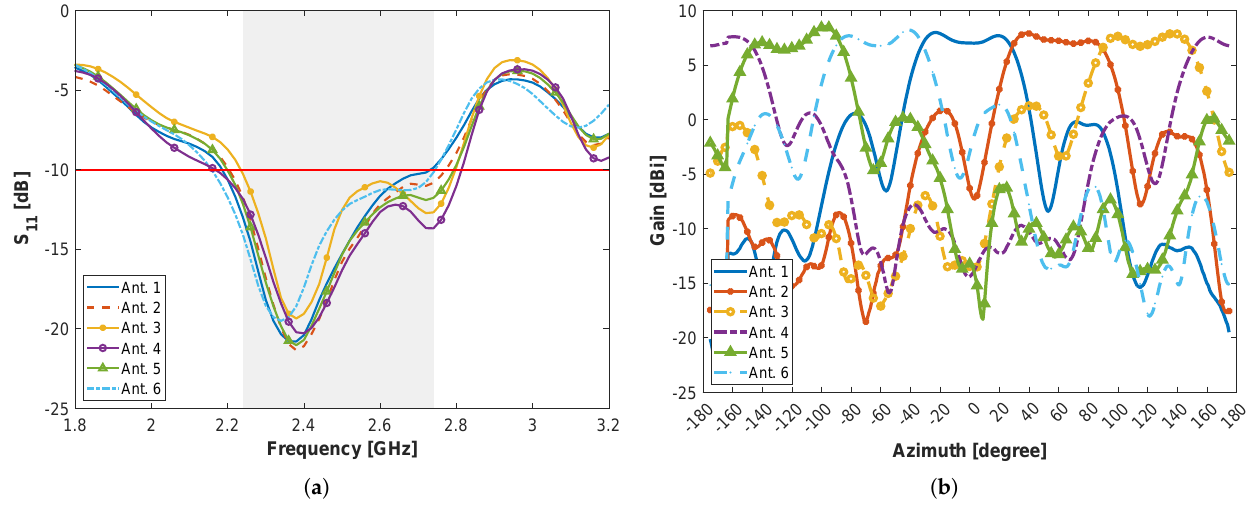
Figure 7. Multi-sector BS antenna: ( a ) S 11 -parameter and ( b ) radiation pattern in the azimuth plane, per antenna element, considering the remaing ports in the OFF